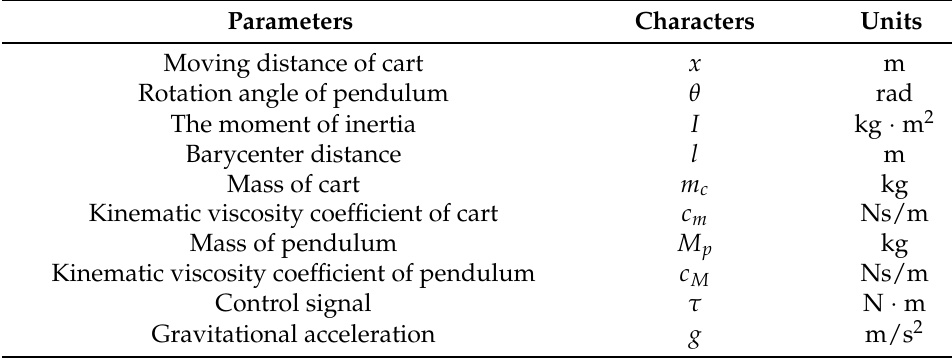
Table 1. Introduction to parameters of robot